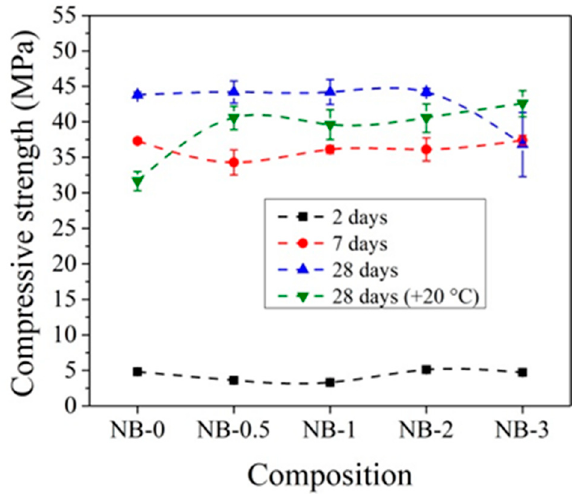
Figure 14. Compressive strength of concrete with CEM IIN samples at 0 °C temperature initial curing (28 days (+20 °C)—reference samples prepared and cured at +20 °C).